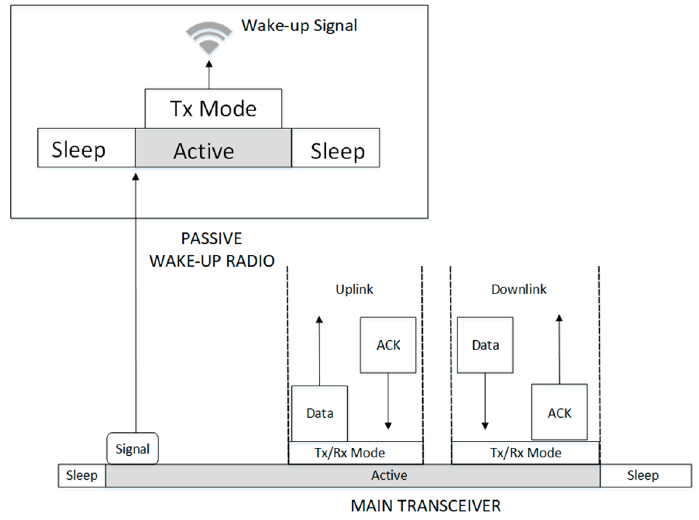
Figure 4. Transmission process.